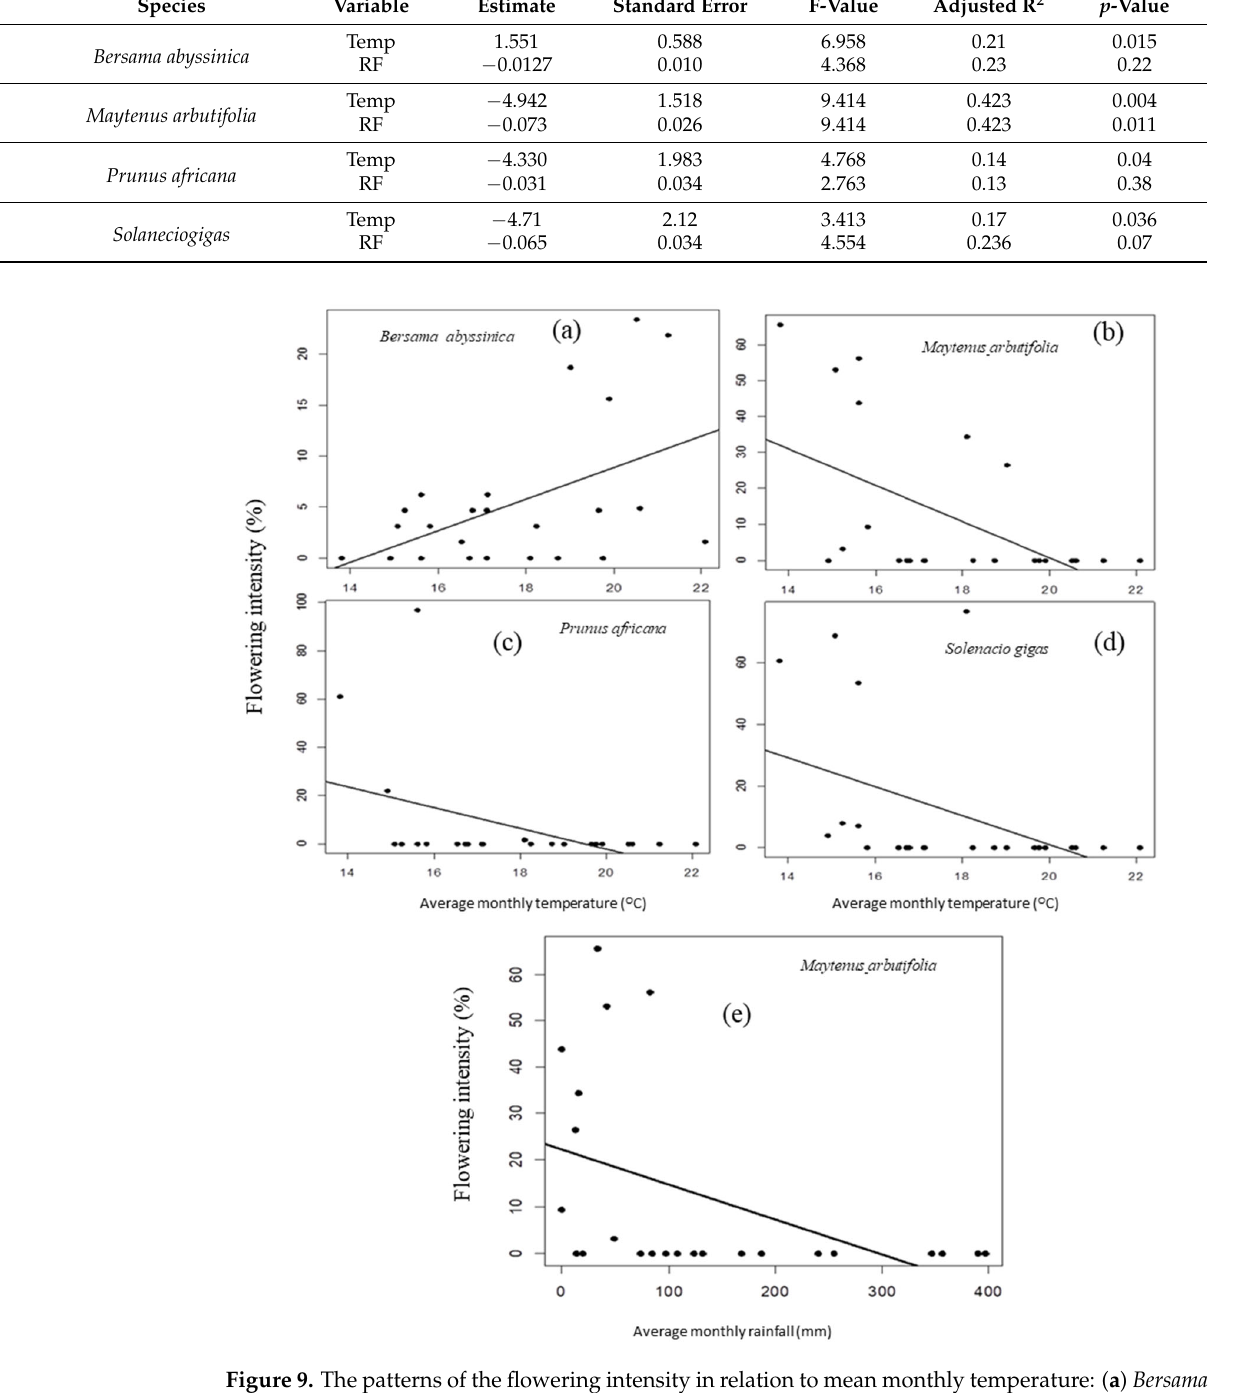
Figure 9. The patterns of the flowering intensity in relation to mean monthly temperature: ( a ) Bersama abyssina , ( b ) Maytenus arbutifolia , ( c ) Prunus africana and ( d ) Solanecio gigas , and in relation to monthly rainfall: ( e ) Maytenus arbutifolia.